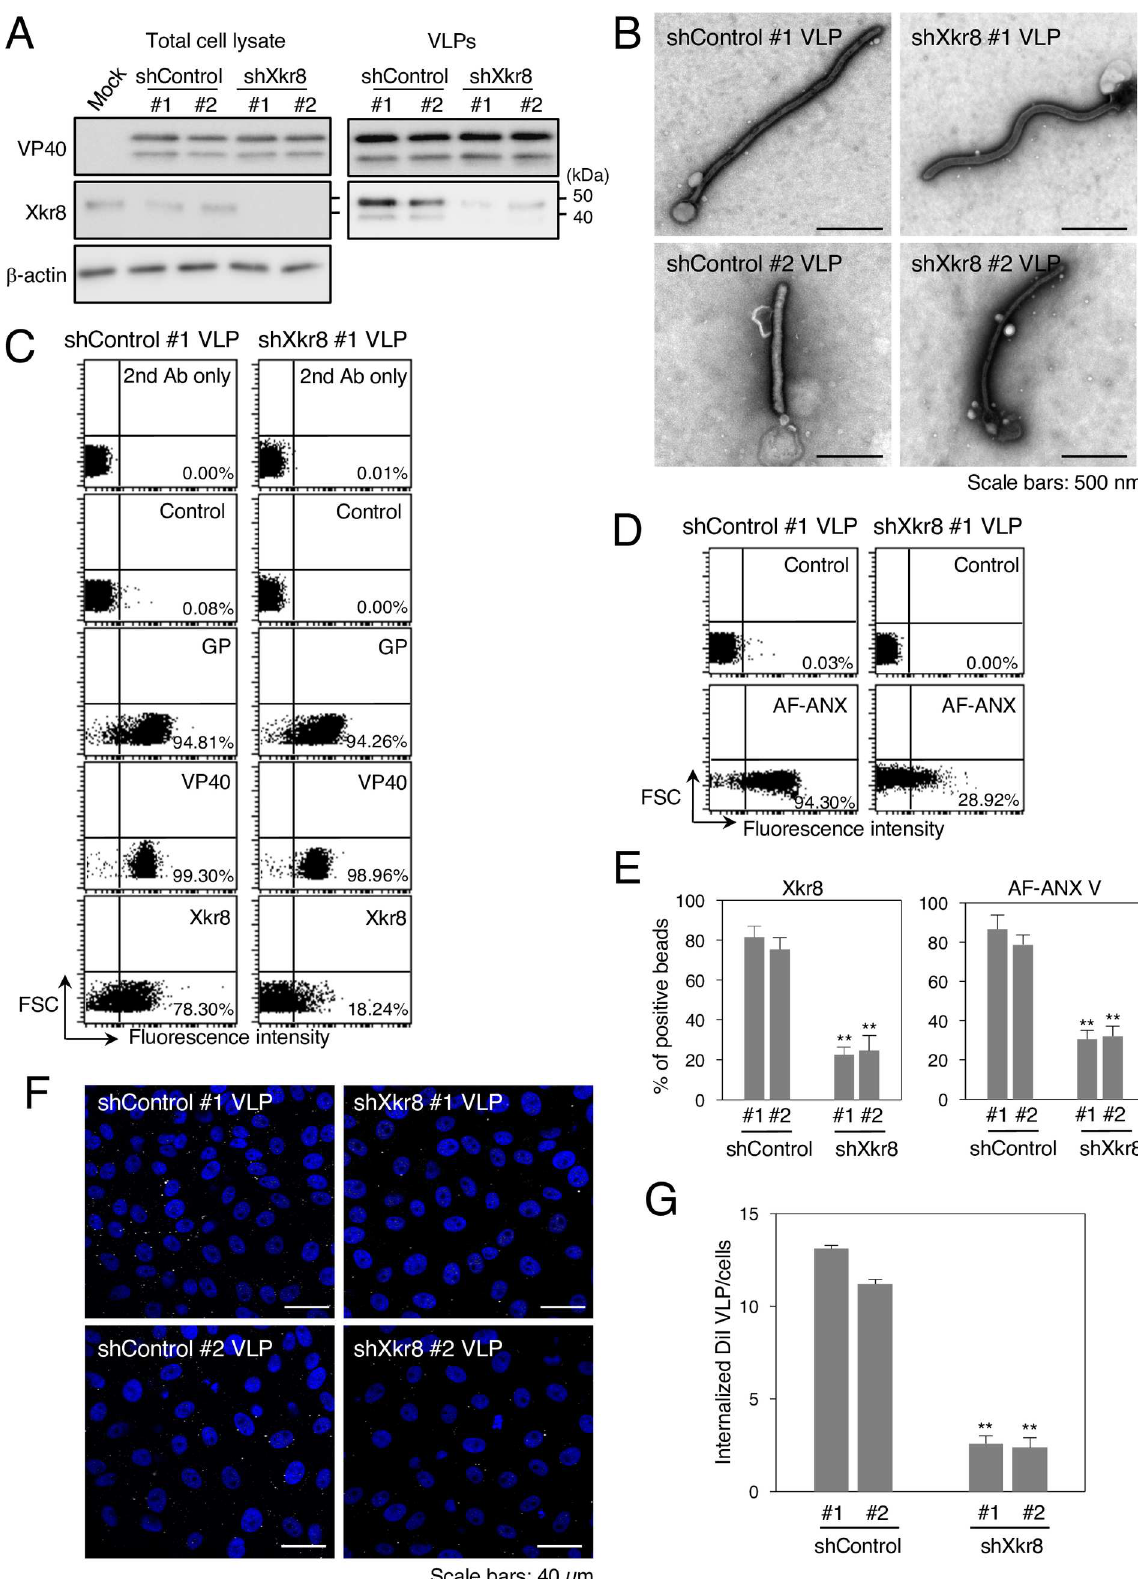
Fig 5. Role of Xkr8 in the externalization of PS on Ebola VLPs and PS-dependent VLP internalization. (A) Downregulation of Xkr8 by shRNA. Individual 293T clones transduced by shRNA plasmids were transfected with the expression plasmids of EBOV VP40, GP, and NP. At PLOS Pathogens| https://doi.org/10.1371/journal.ppat.1006848 January16,